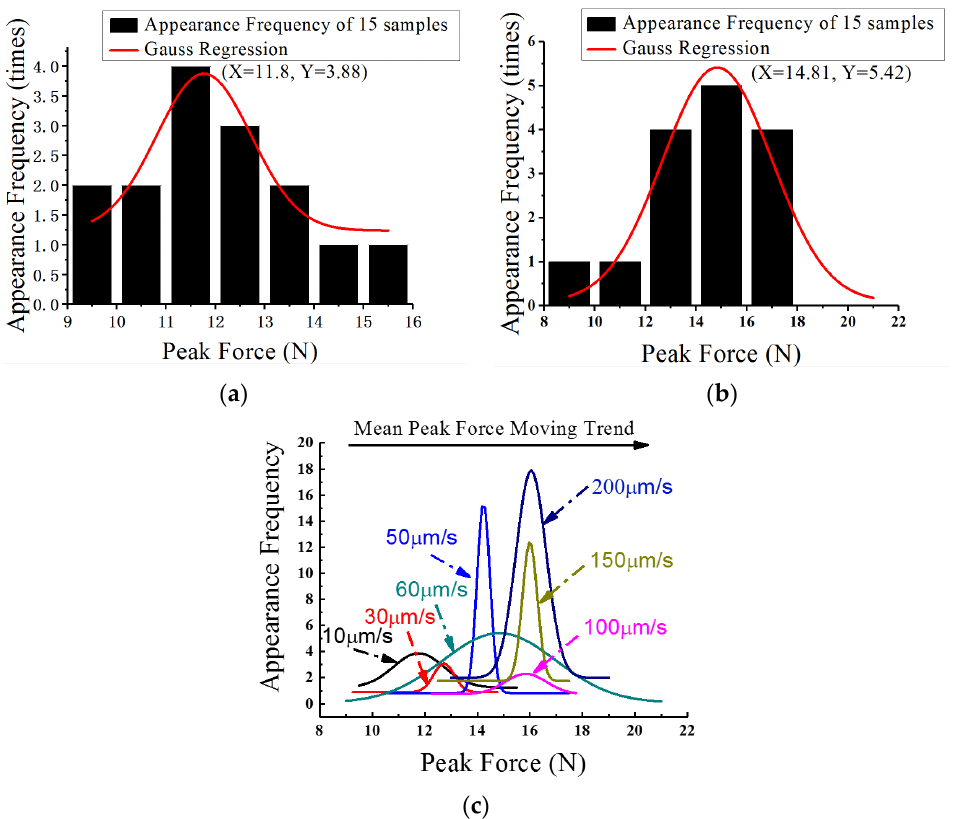
Figure 4. Peak force distributions of typical speed tests and Gaussian regression curves: ( a ) 10 μ m/s; ( b ) 60 μ m/s; ( c ) seven different speeds.